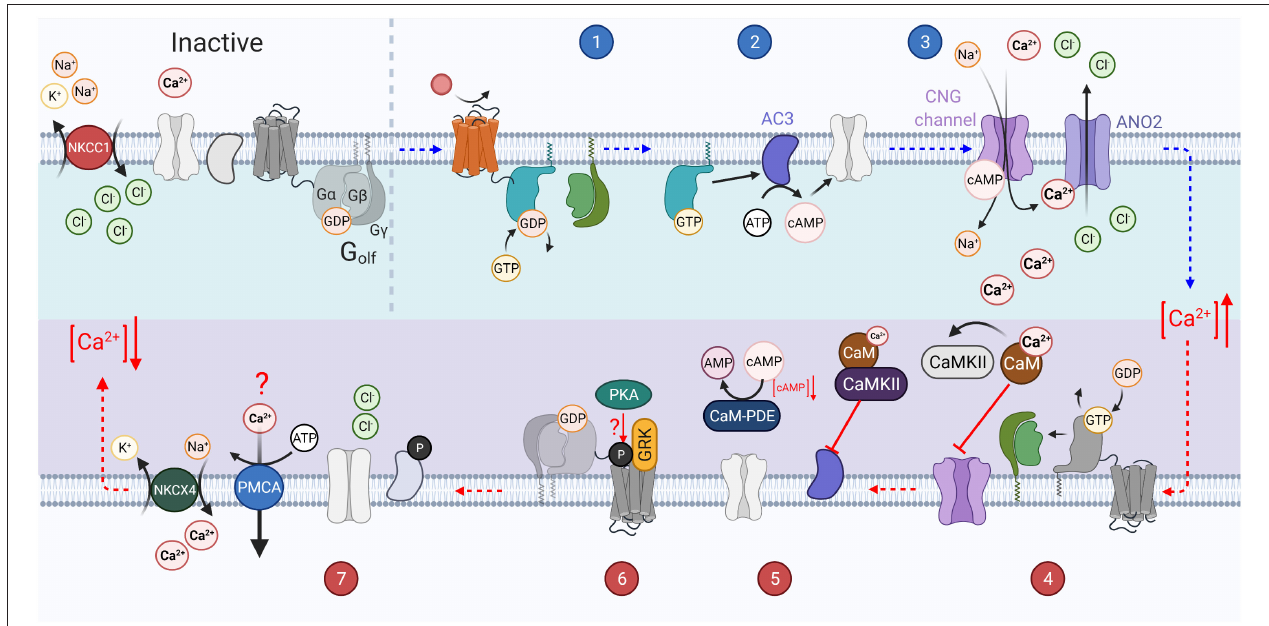
FIGURE 3 | The vertebrate olfactory transduction cascade, inactivation, and adaptation mechanisms: OSNs maintain a high intracellular Cl − ion concentration through the constitutive activity of the NKCC1 transporter, which transports Cl − ions into the cell using the energy from the export of Na + and K + ions. An odorant binds to the G-protein coupled olfactory receptor (OR) on the cilium of the sensory neuron. The activated receptor in turn activates G olf (step 1). The G α olf subunits then activate adenylyl cyclase III (AC3) which catalyzes the conversion of ATP to cAMP (step 2). The increasing concentration of cAMP causes the opening of CNG channels on the membrane. This causes an influx of Ca 2 + ions. The increasing Ca 2 + concentration also causes the opening of the calcium activated chloride ion channel, ANO2, which further depolarizes the cell as the increased intracellular chloride gradient causes an efflux of Cl − . The increased Ca 2 + concentration leads to several inactivation mechanisms (step 3). GTP bound to the active G α olf subunit is hydrolyzed to GDP, inactivating it, and causing it to re-associate with the βγ subunits. Ca 2 + binds to Calmodulin (CaM) which in turn activates CaMKII. Calmodulin potentially reduces CNG channel affinity for cAMP through interaction with the A-subunit of the channel (step 4). CaMKII inhibits the activity of AC3 by phosphorylating it, preventing the generation of cAMP. PDE1C is also activated by Ca 2 + bound CaM and accelerates the hydrolysis of cAMP to AMP (step 5). GRK mediated phosphorylation of the OR (step 6). Intracellular Ca 2 + concentration is re-established through the activity of ion exchangers (NCKX4 and possibly PMCAs), and the high intracellular Cl − concentration is reestablished through NKCC1 activity and the closure of ANO2 channels (step